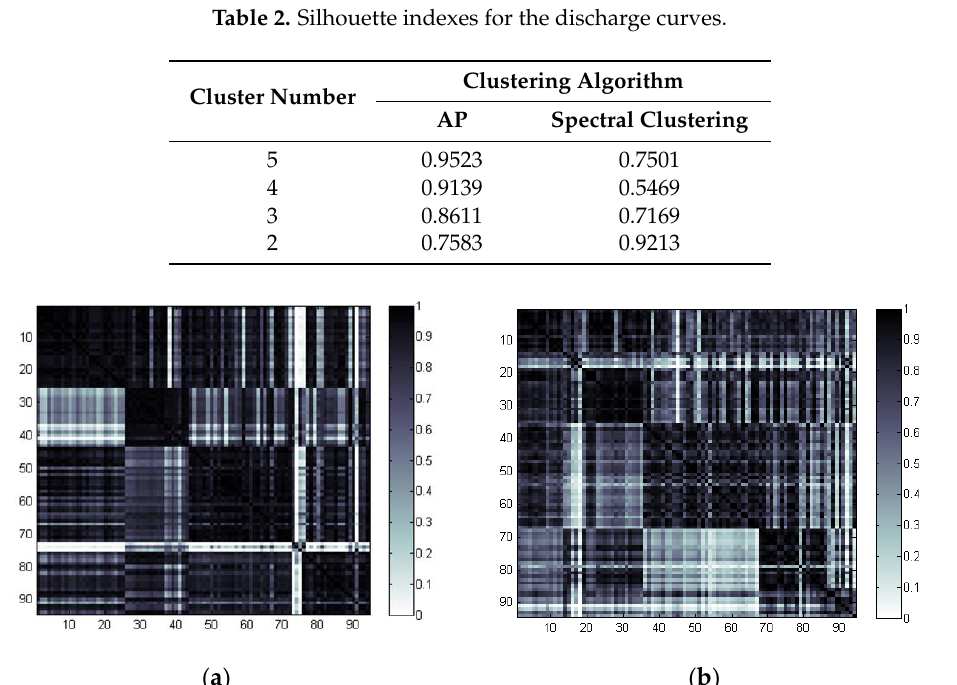
Figure 7. Clustering result for the charge curves with the proposed method.